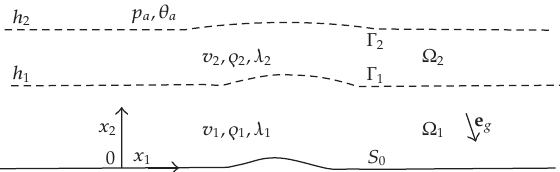
Figure 1: Flow domain of a nonisothermal two-fluid inclined film